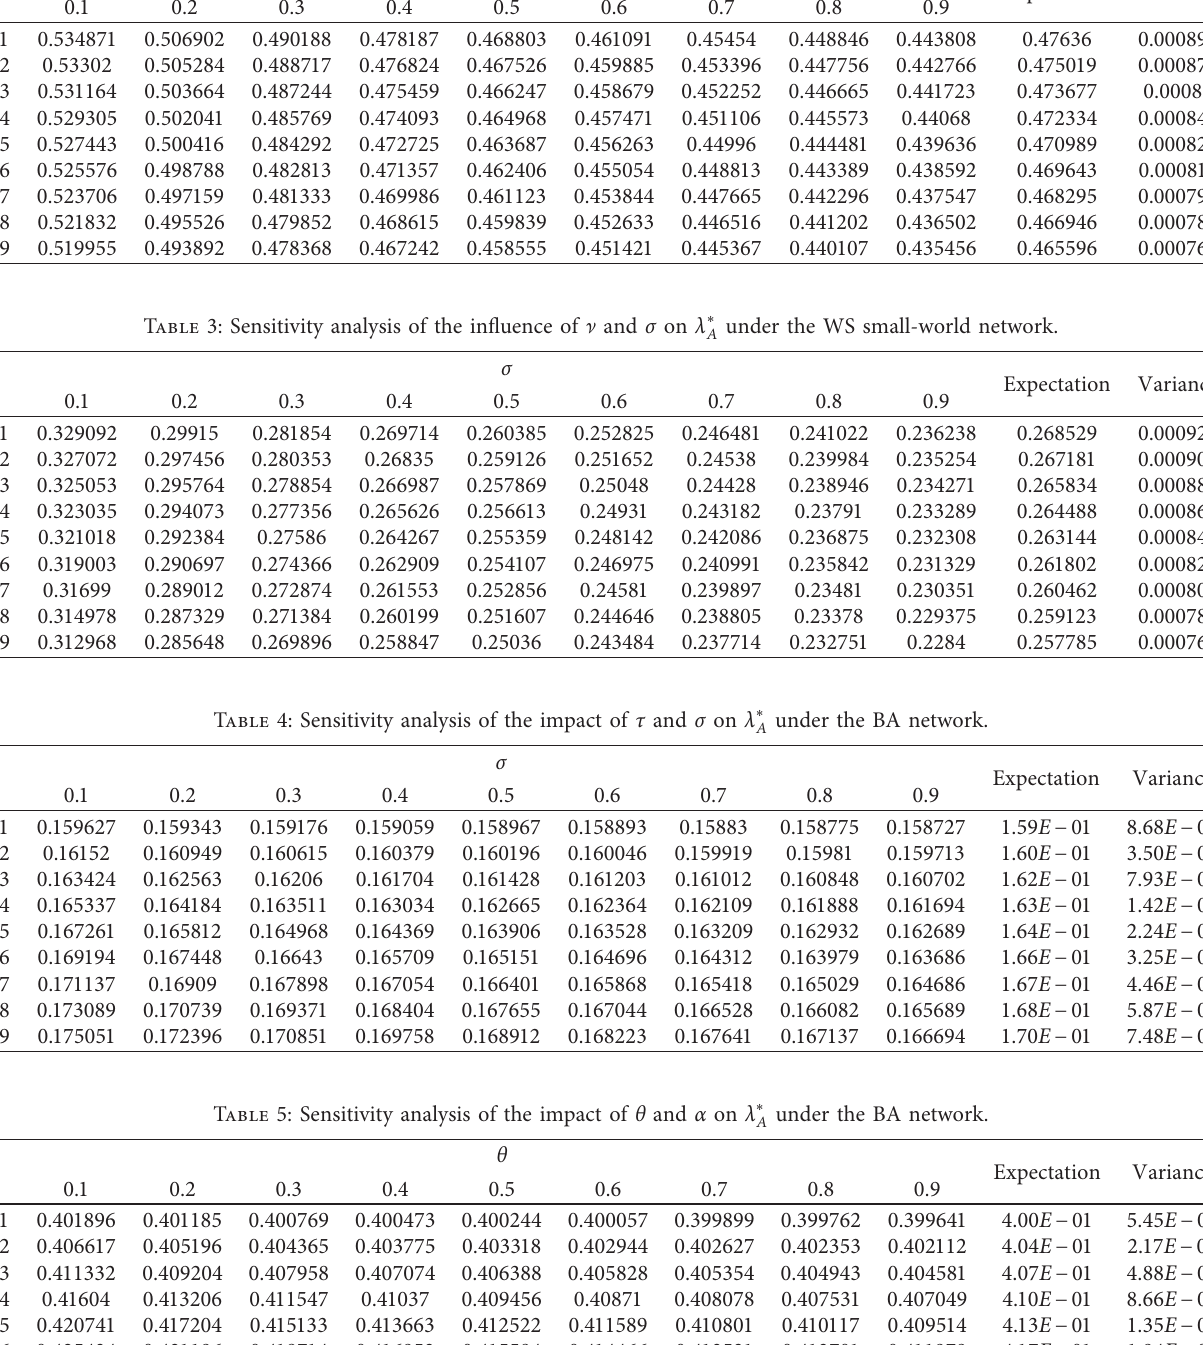
Table 2: Sensitivity analysis of the influence of ] and σ on λ ∗